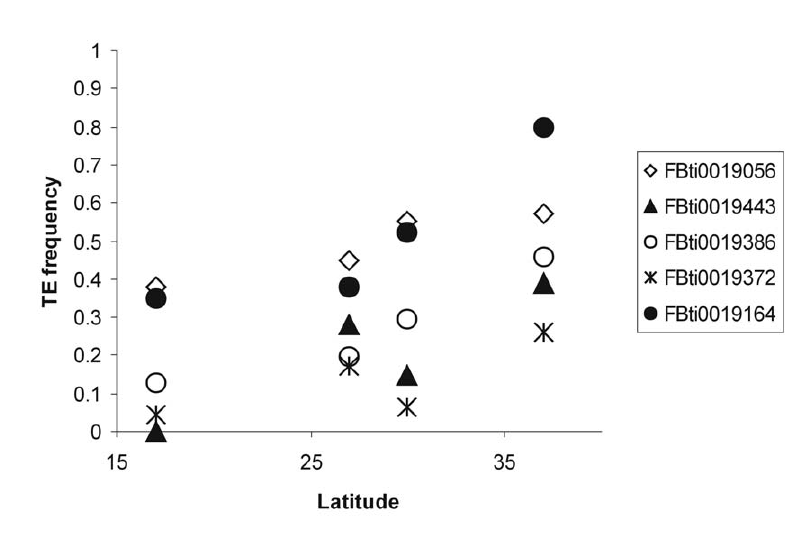
Figure 3. Frequency of five TEs that showed significant patterns of population differentiation in four populations collected along the east coast of Australia in 2008.